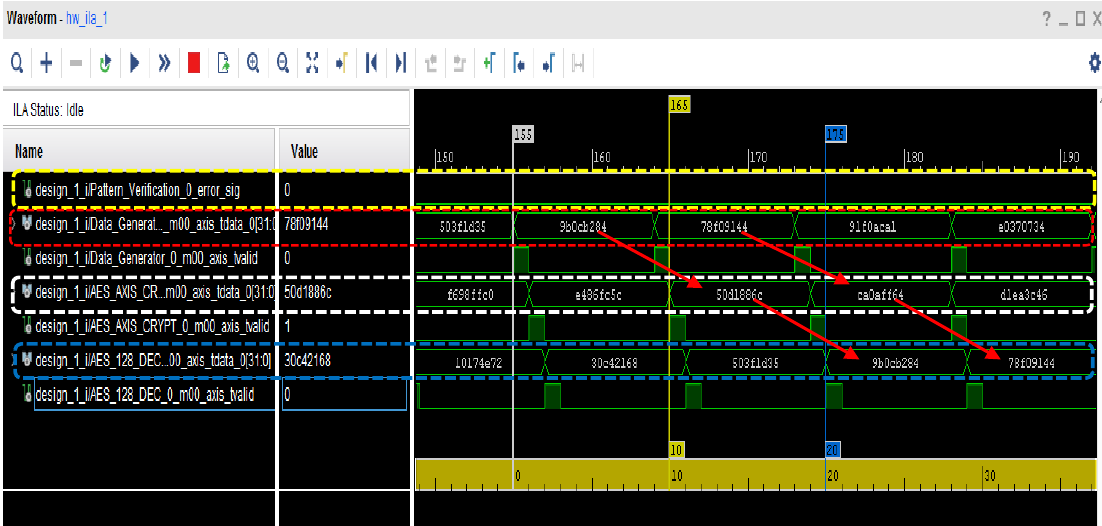
Figure 24. Temporal trends with shown the plaintext data packets entering the system (red-dashed box), the encrypted ones delivered by the encryption block to the decryption block (white-dashed box) and finally decrypted packets provided in output by the decryption block (blue-dashed box); as evident, the plaintext data packets provided in input to the system are equal to those provided by the decryption block (as indicated by the red arrow), also demonstrated by error_sig signal, which remains low along the observation period (yellow-dashed box).